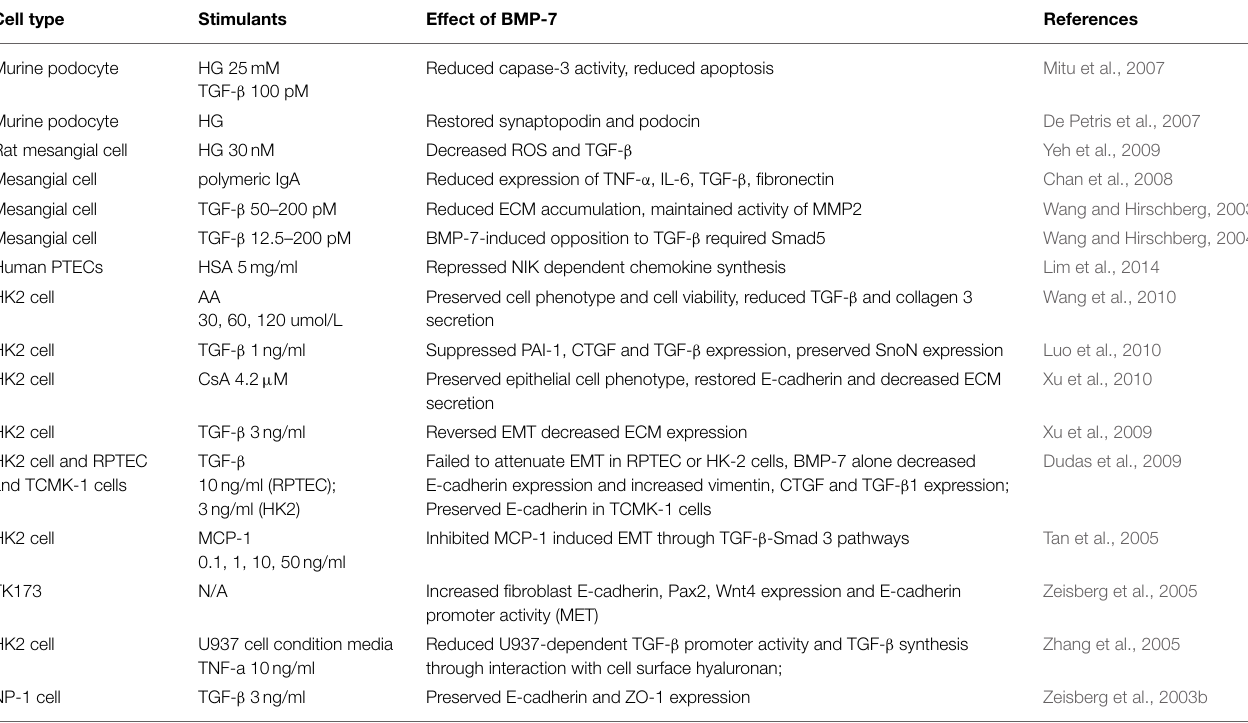
TABLE 2 | Published studies of BMP-7 as a therapeutic tool in different cell types of kidney